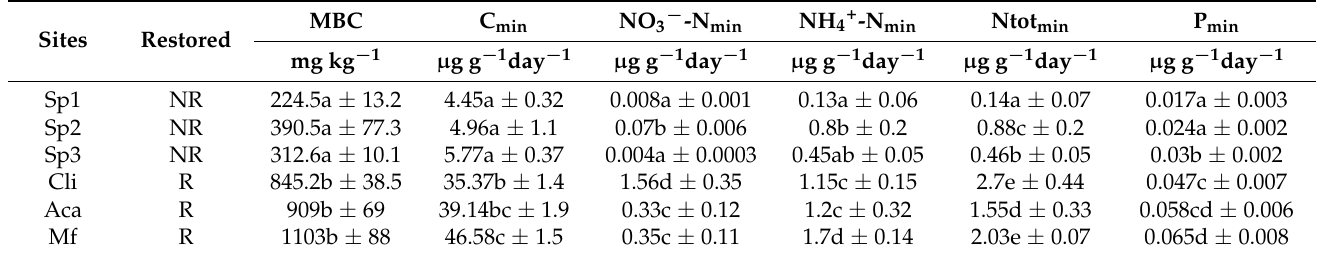
Table 2. MBC: microbial biomass carbon; C min (SIR); C min , NH 4+ -N min , NO 3 − -N min , P min : organic C mineralization rate, mineralized NH 4+ -N, mineralized NO 3 − -N, total N mineralization rate, organic P mineralization rate. All mineralization rates are expressed in micrograms per gram of soil per day. NR: non-restored sites, R: restored sites. Sp1, Sp2 and Sp3 are non-restored mining sites. Cli is a restored site with C. racemosa , Aca is a restored site with A. mangium , and Mf is a mixed